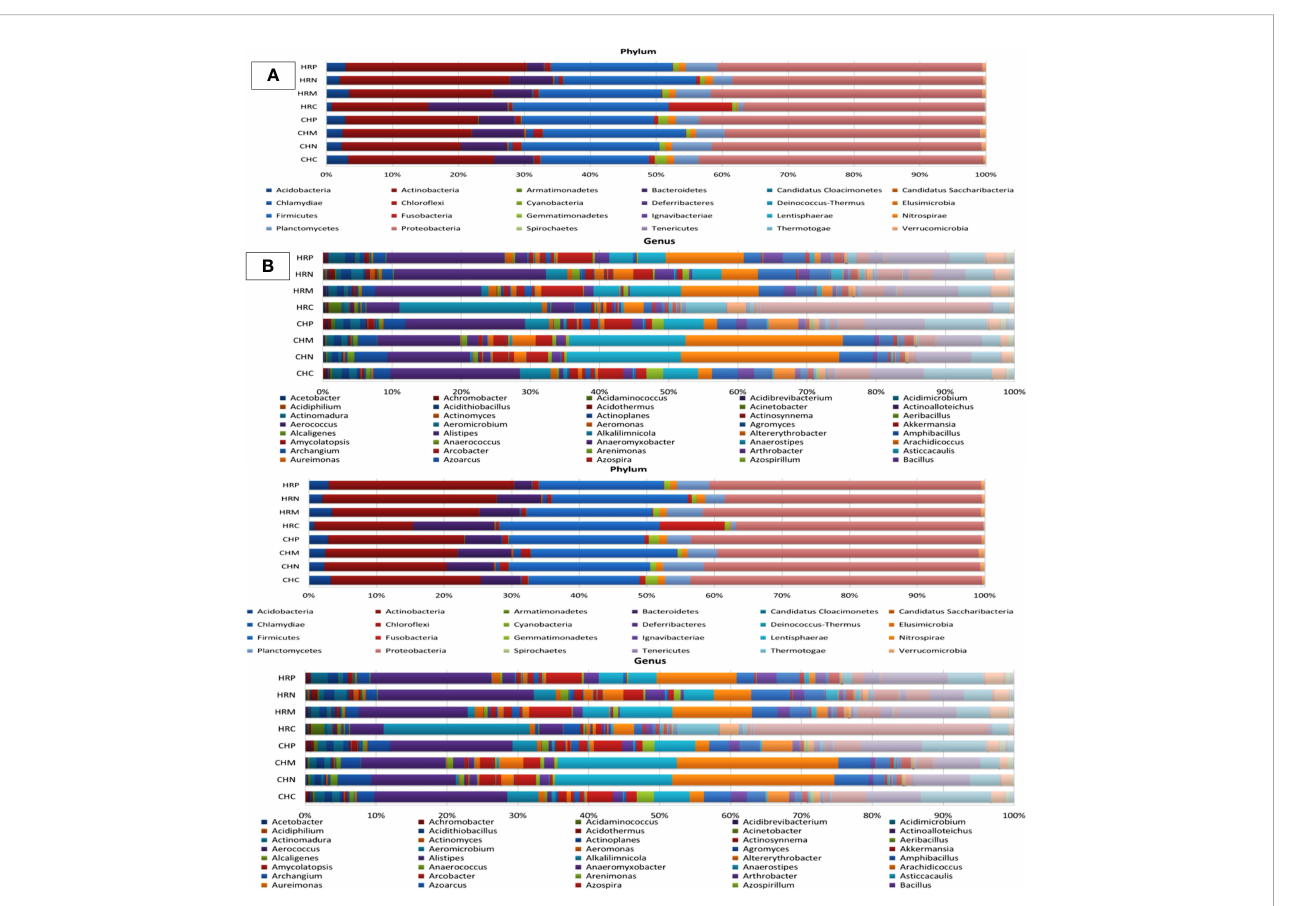
FIGURE 3 Stacked bar plot representing relative abundance; (A) Phylum and (B) Genus distribution among treatment and control under different locations. Where, HRP = Harsil Pre-sowing Soil, HRC = Harsil control soil, HRM = Harsil MP1 treated soil, HRN = Harsil N26 Treated soil, CHP = Chakrata Pre-sowing soil, CHC = Chakrata control soil, CHM = Chakrata MP1 treated soil, CHN = Chakrata N26 Treated